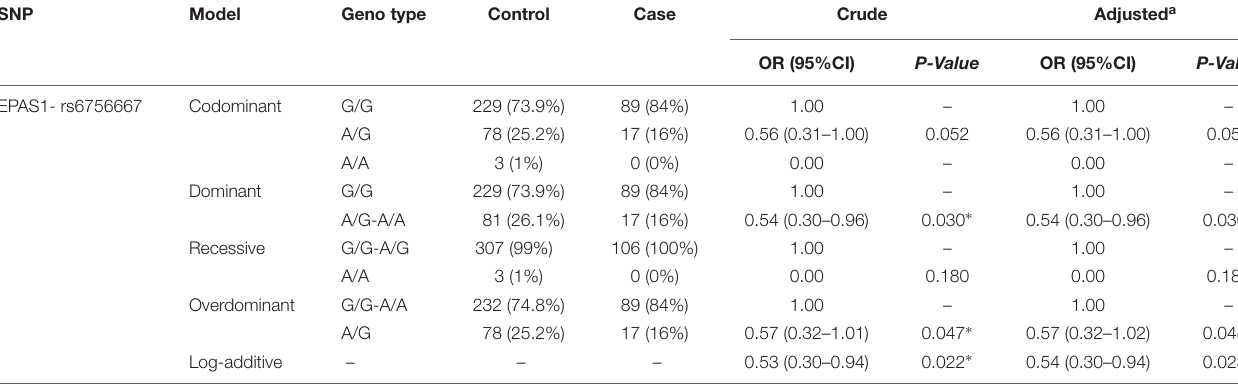
TABLE 4 | Single nucleotide polymorphism of rs6756667 analysis under different genetic models with the risk of HA appetite loss. SNP Model